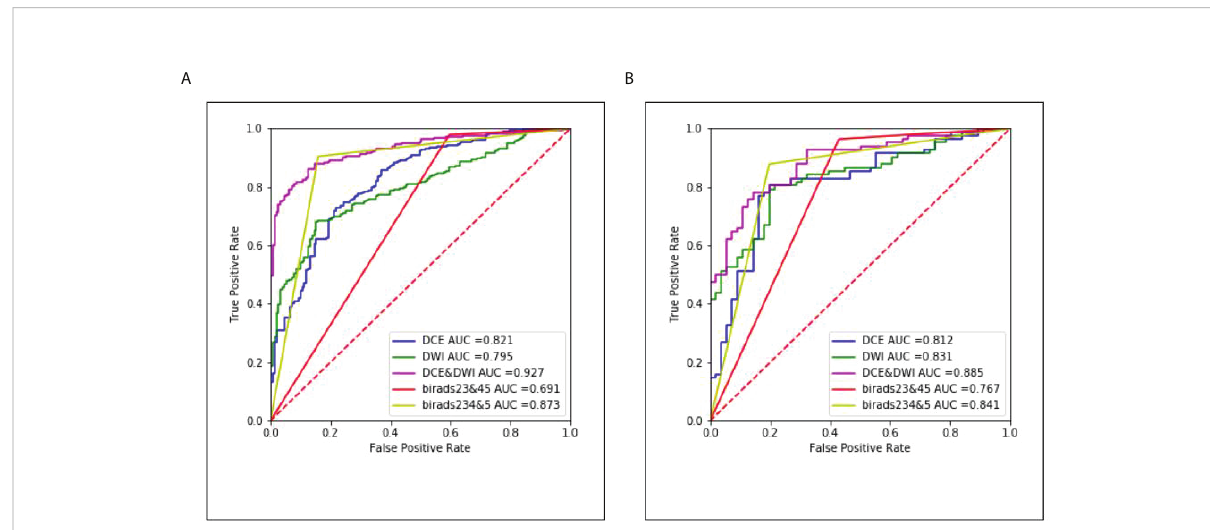
FIGURE 6 The corresponding ROC curves of the three different models and radiologists. (A) Results of the internal test set and (B) results of the external test